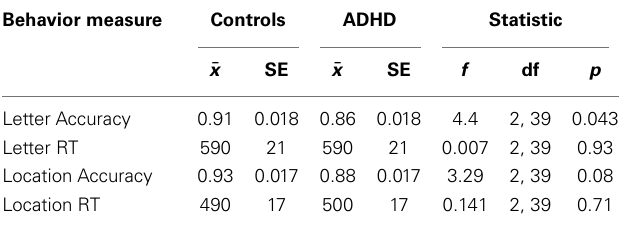
Table 2 | Group differences in behavior